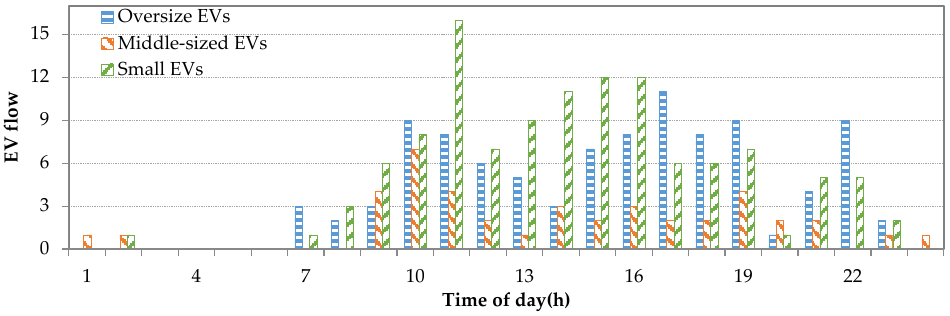
Figure 7. The station inflow of the different types EVs on highways at different time periods.